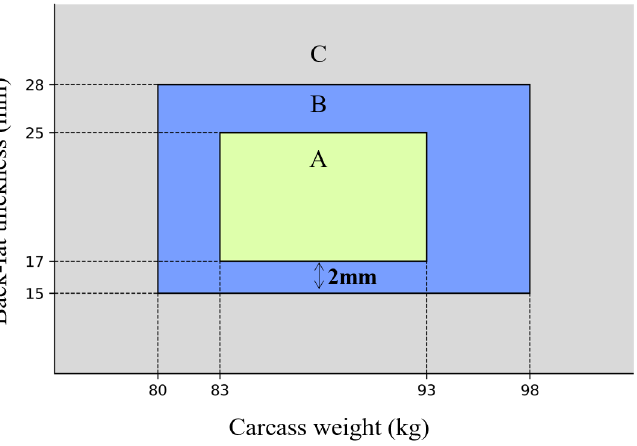
Figure 7. Initial grades in the Korean grading system according to the carcass weight and back-fat thickness. The initial grade is ranked in order of ‘A’, ‘B’, and